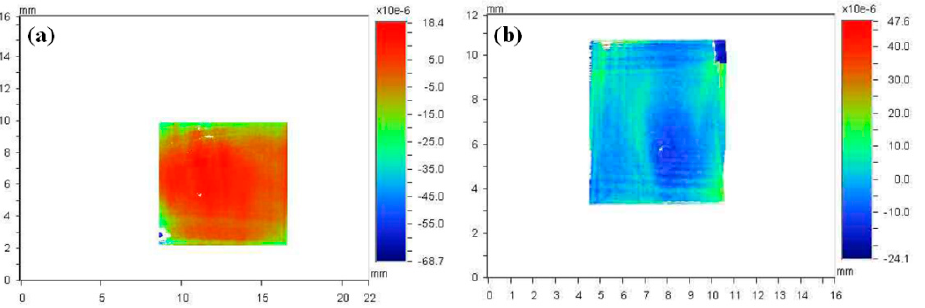
Figure 6. Optical homogeneity values of CBO crystals grown via the ( a ) seed-submerged growth method and ( b ) the TSSG method.